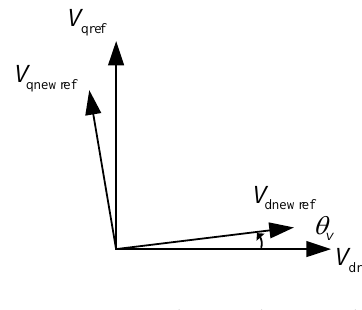
Figure 7. Virtual impendence angle.